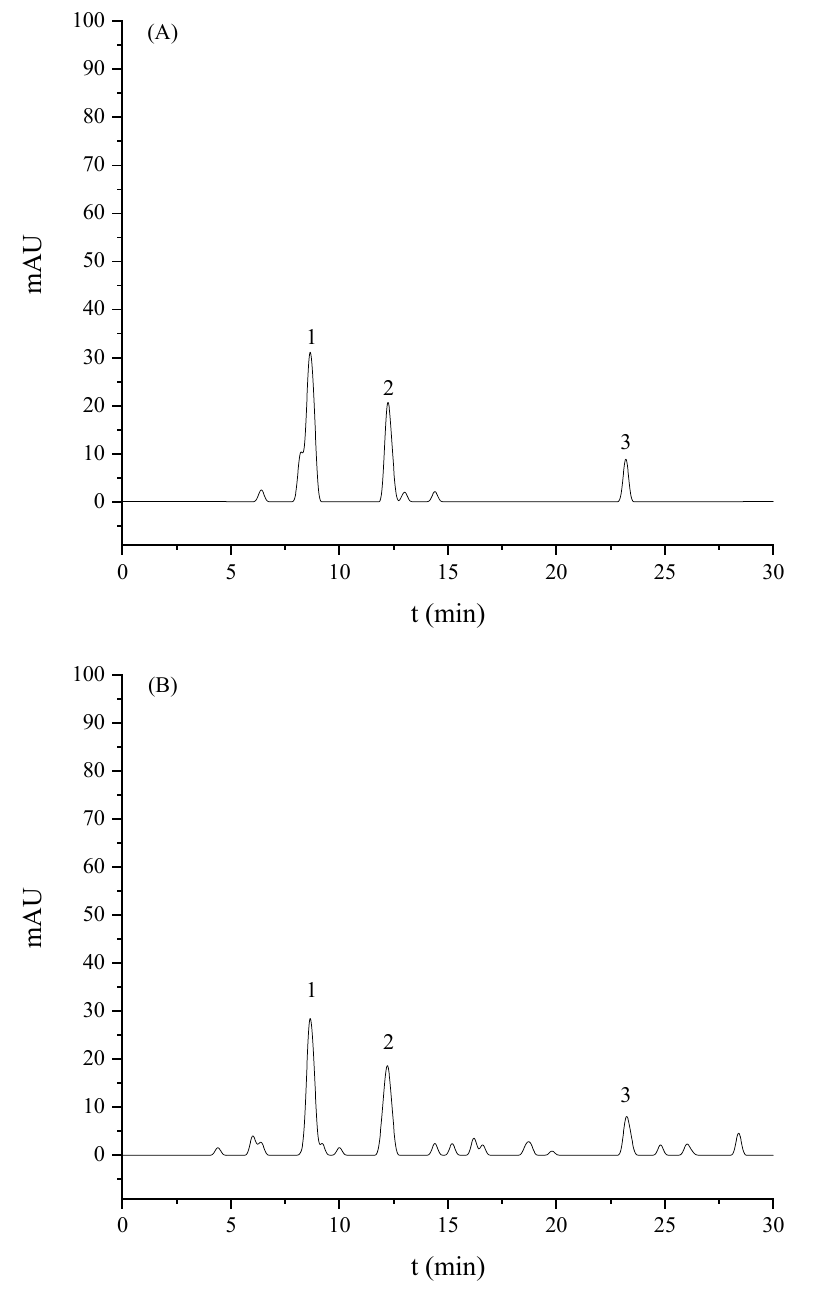
Figure 1. HPLC chromatograms of mixed standards ( A ) and FPMB ( B ).